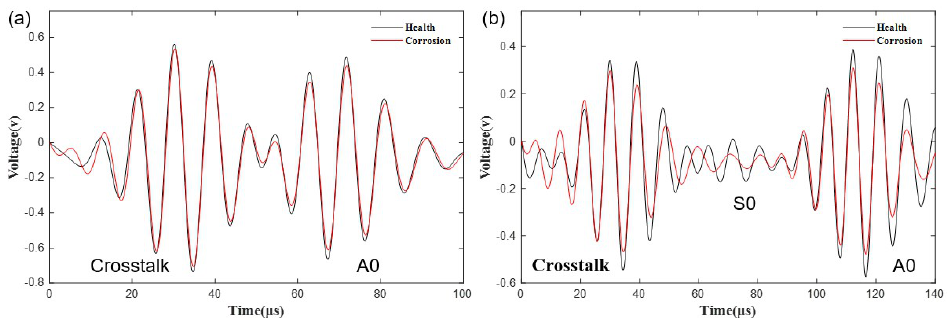
Figure 9. Comparison between health signal and damaged signal ( a ) on paths 3–5, ( b ) on paths 6–12.